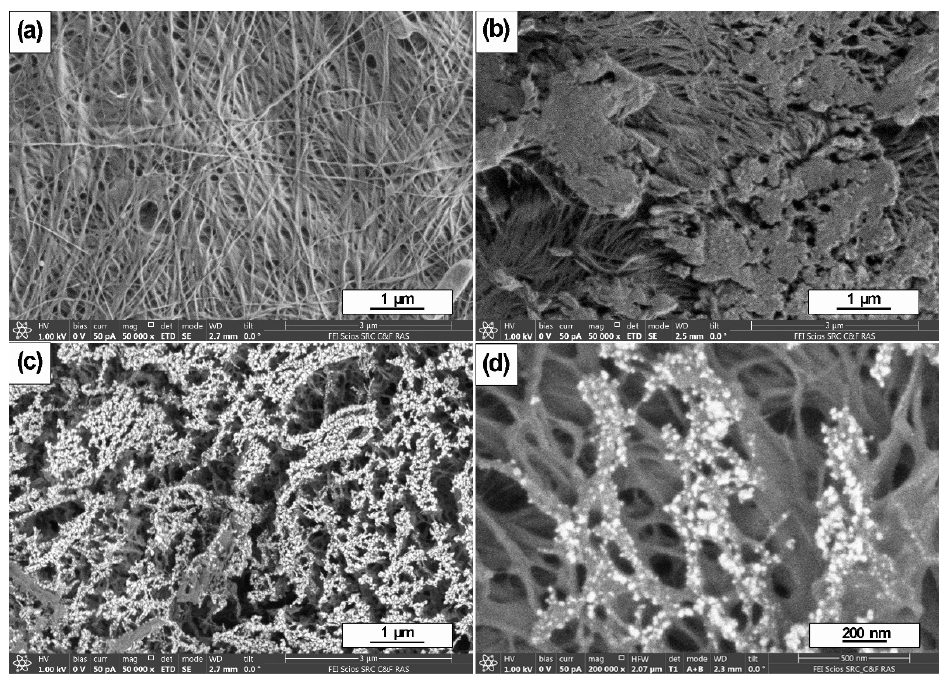
Figure 2. SEM images of the morphology of the initial bacterial cellulose film (BC) ( a ), BC after plasma treatment (BCP) ( b ) and BSE images of the BCP with agglomerates of Ag nanoparticles lying on its surface after Ag magnetron sputtering ( c , d ).